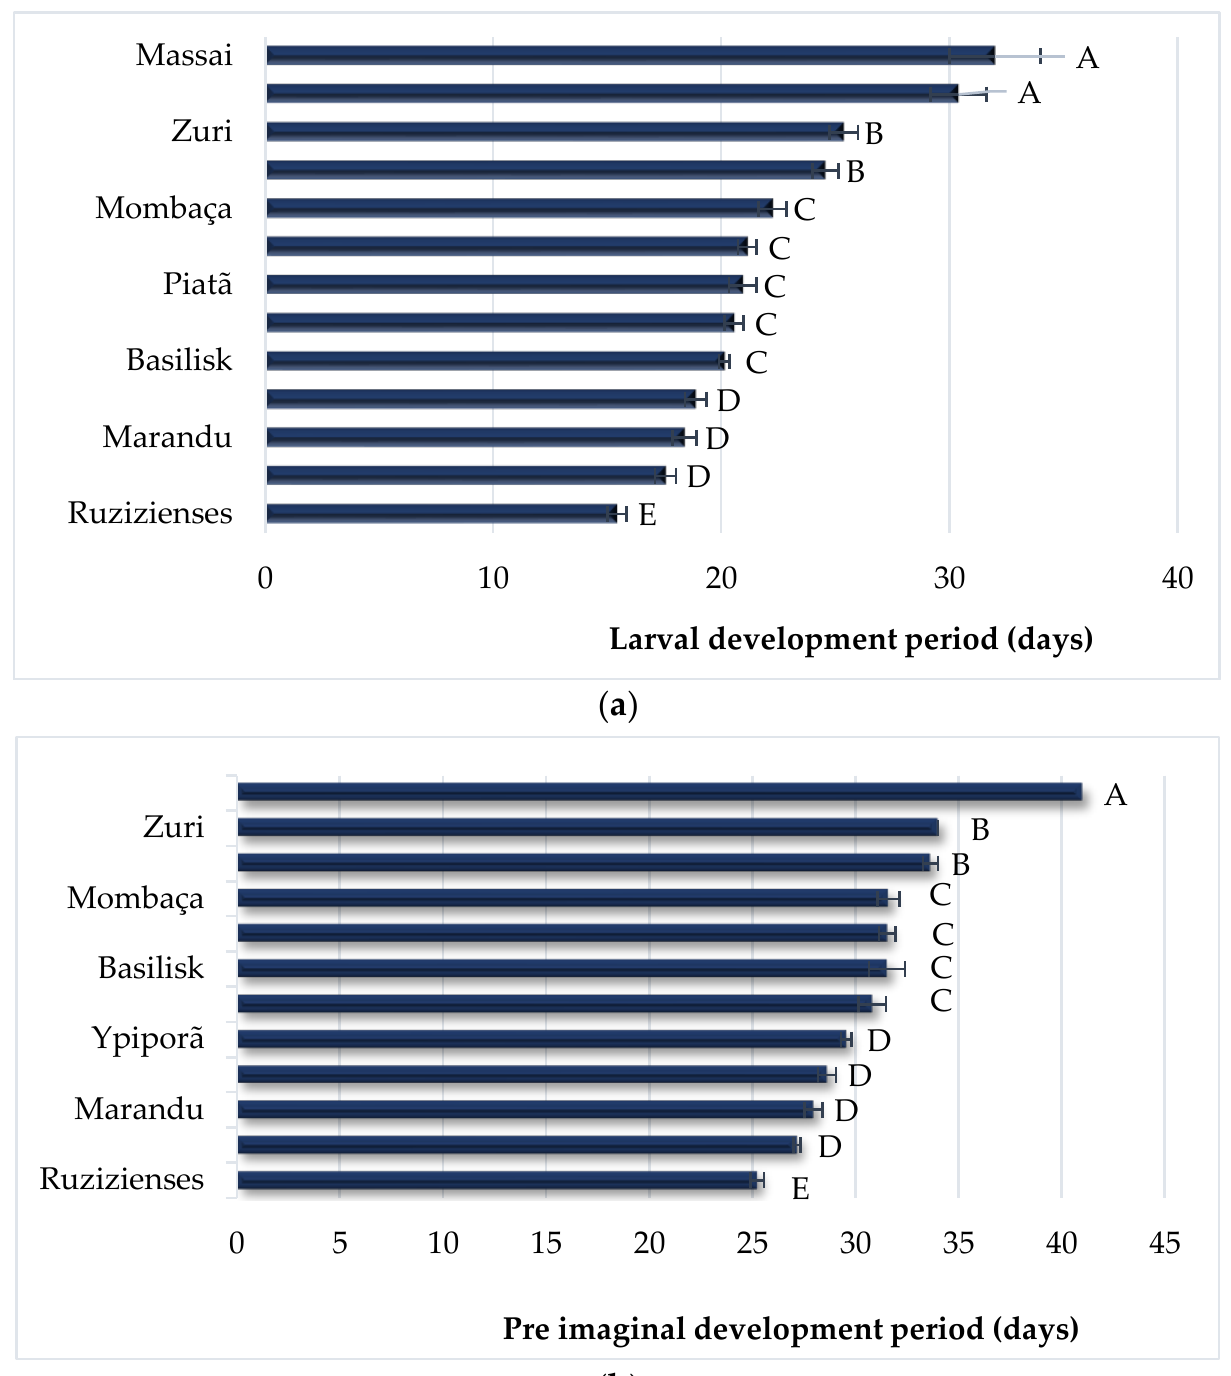
Figure 3. Larval development time (days) ( a ) and pre-imaginal development time ( b ) of Spodoptera frugiperda on different forage and cover crops. Means followed by the same letter do not differ from each other by the Scott–Knott test ( p > 0.05). The combination of biological variables can be seen in the AI (Figure 4). For P. maximum ‘Massai’ and ‘Tamani’, the AI values were equal to zero, as in this case, S. frugiperda did not reach the pupae stage. The highest AI values were observed for B. ruziziensis